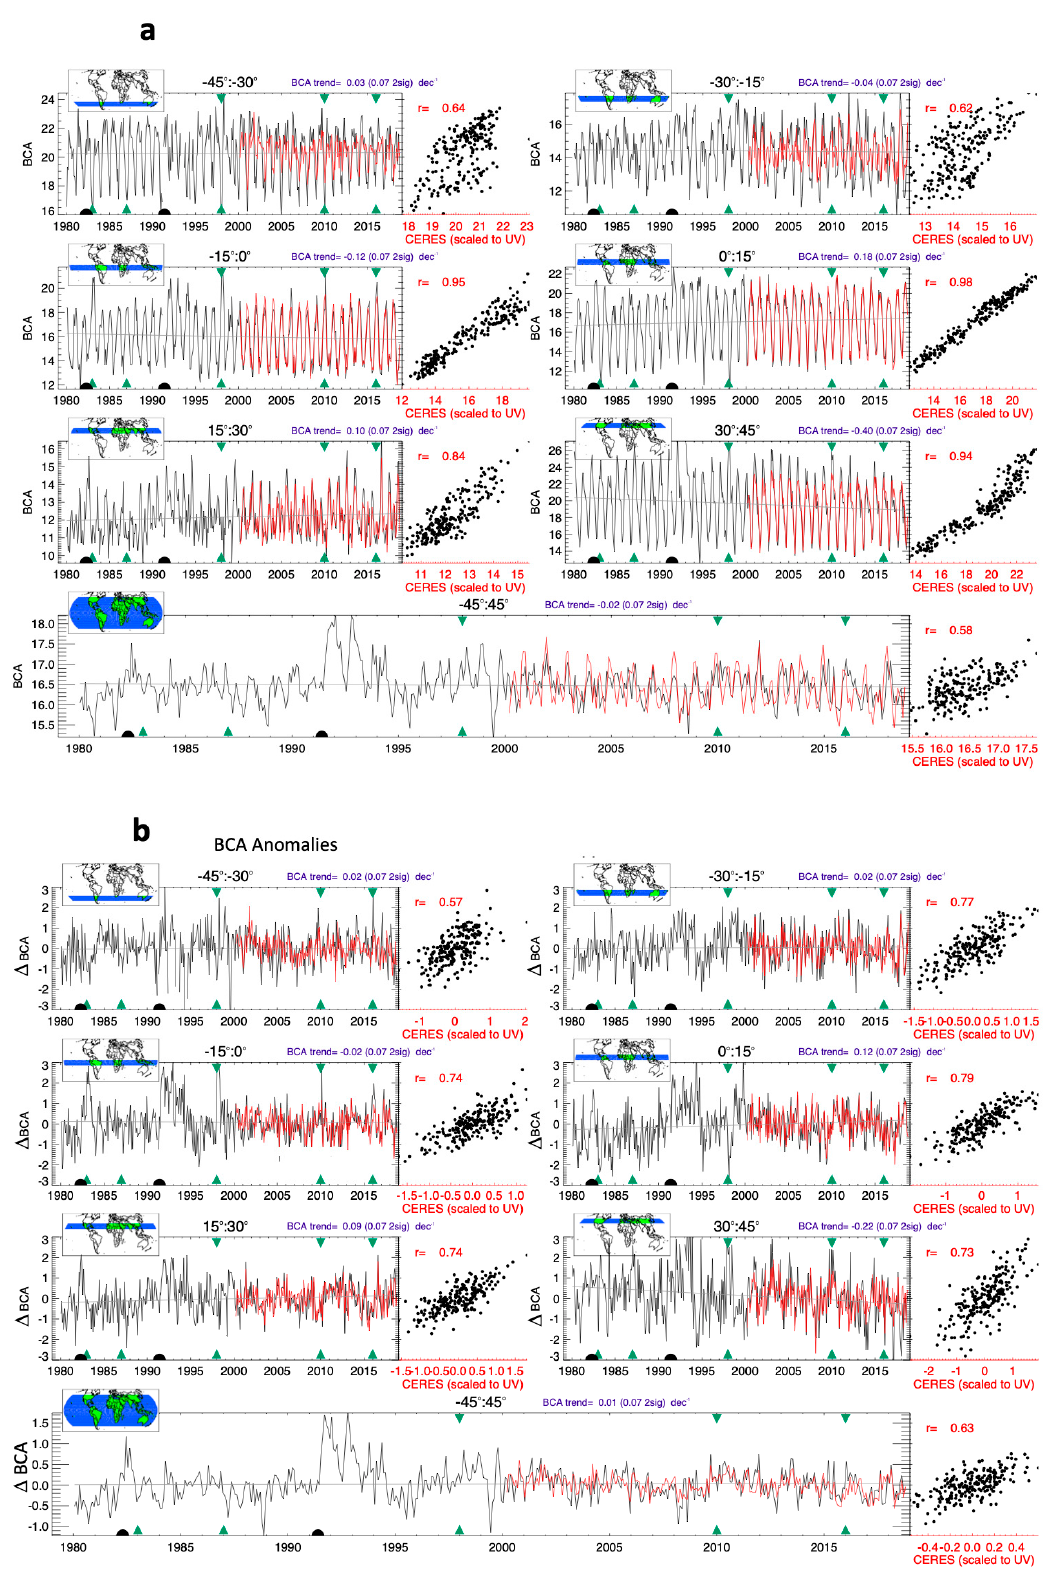
Figure 7. UV black-sky cloud albedo (%) (black trace) with shortwave cloud albedo from CERES (red trace) over ocean and land: ( a ) monthly values and ( b ) de-seasonalized monthly anomalies. The CERES SW cloud albedos have been scaled to be a proxy for the UV BCA. A single scaling factor for each 15 ◦ wide latitudinal band is used. In addition, on RHS there is a scatter plot of UV BCA versus CERES. Years with El Niño conditions (green triangles) and major volcanic eruptions (black semi-circles) are